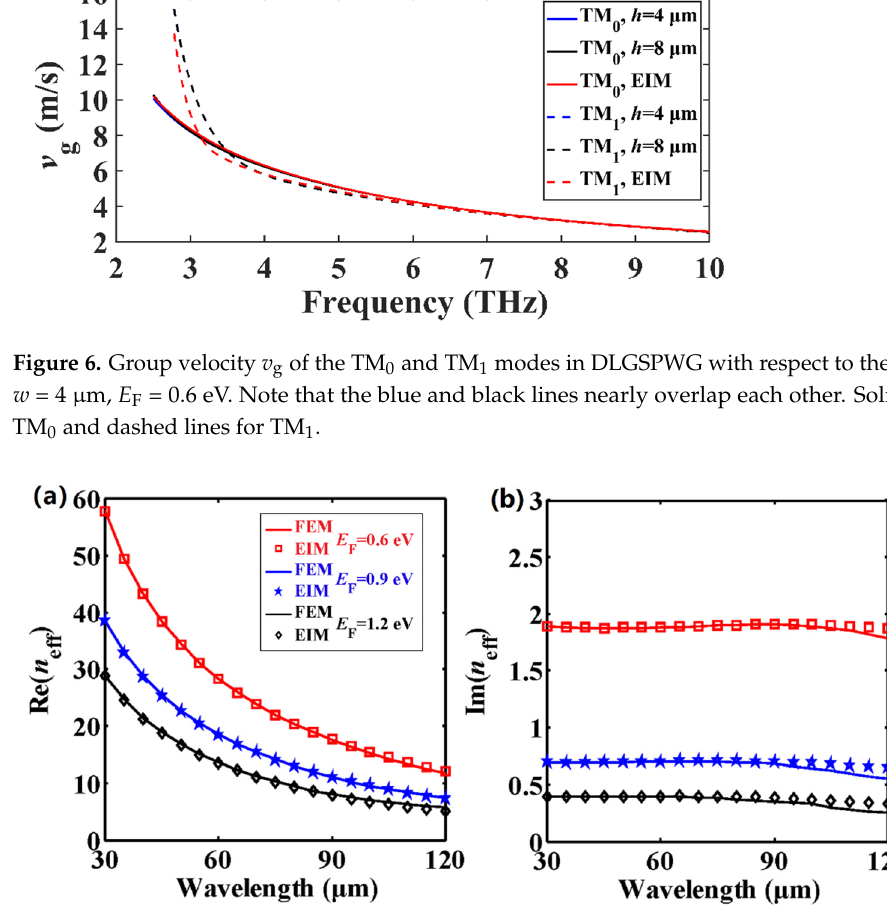
Figure 7. ( a ) Real and ( b ) imaginary parts of the effective mode indices of the fundamental mode in DLGSPWG with respect to the wavelength at different E F values. w = 4 μ m, h = 8 μ m.